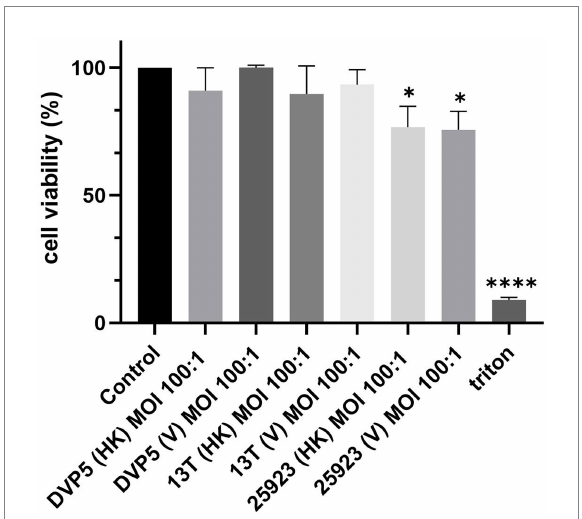
FIGURE 7 S. saccharolyticus has no cytotoxic effect on THP-1 cells. S. saccharolyticus does not induce cytotoxcity in THP-1 cells after 24 h of infection. A WST-8 assay was applied to differentiated THP-1 cells exposed to the following bacterial strains: S. saccharolyticus strains DVP5-16-4677 (DVP5; subclade 2) and 13 T0028 (13 T; subclade 1) and S. aureus ATCC 25923. Triton X-100 was used as positive control. HK, heat-killed; V, viable; MOI, multiplicity of infection. Two biological replicates were performed for each strain. Results are expressed as mean ± SEM, and significant differences compared to untreated cells are highlighted by asterisks (*, p < 0.05 ; ****, p < 0.0001; Welch’s t -